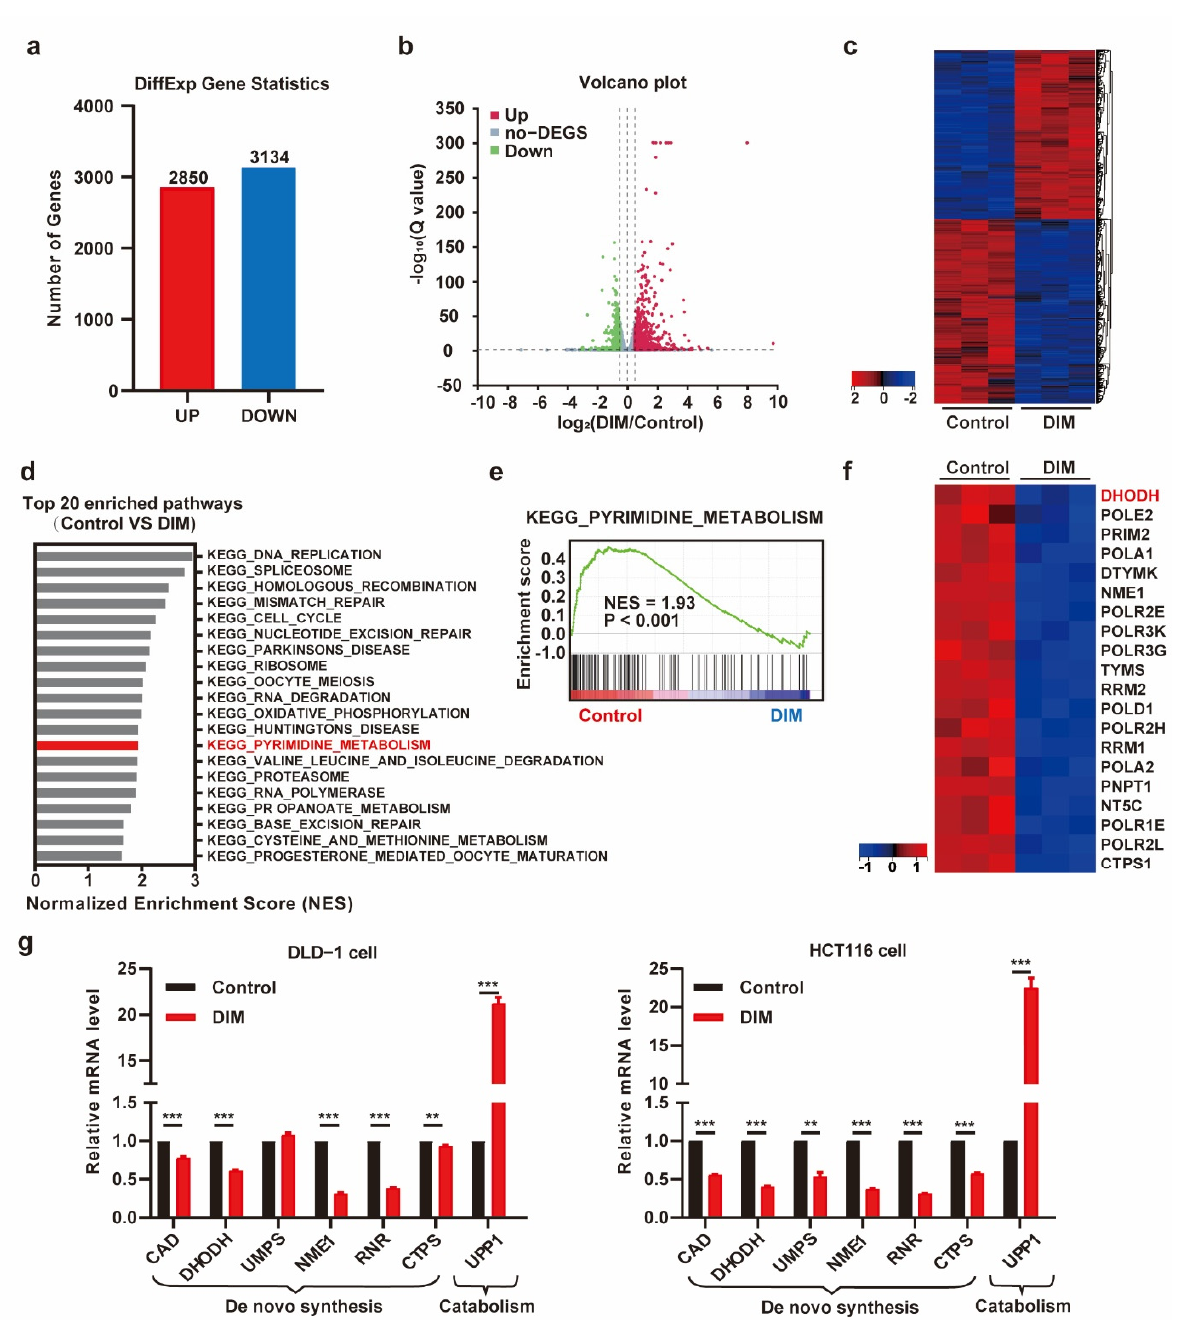
Figure 2. DIM treatment attenuates the pyrimidine metabolism in CRC. ( a ) Statistics for both up- and down-regulated number of the differently expressed genes (DEGs). ( b ) The volcano plot of differential expression genes in DMSO- and DIM-treated DLD-1 cells (|logFC| > 0.5 and p -value < 0.05). ( c ) Heatmap plot of gene expression levels based on RNA-seq data by Sangerbox platform. Data colored in the red–black–blue scheme indicate a relatively higher, average, and lower concentration, respectively. ( d ) Representative top 20 pathways enriched in control group compared to DIM group based on GSEA analysis results. ( e ) Enrichment plots for KEGG_PYRIMIDINE_METABOISM are shown. ( f ) Heatmap plot of top 20 genes ranked in KEGG_PYRIMIDINE_METABOISM. ( g ) DIM dysregulated the transcription of genes in pyrimidine metabolism (CAD, DHODH, UMPS, NME1, RNR, CTPS, UPP1) by RT-PCR. DLD-1 cells and HCT116 cells were treated with 40 µ M DIM for 48 h. Data are presented as mean ± SEM. **, p < 0.01; ***, p < 0.001; unpaired two-tailed Student t -test.